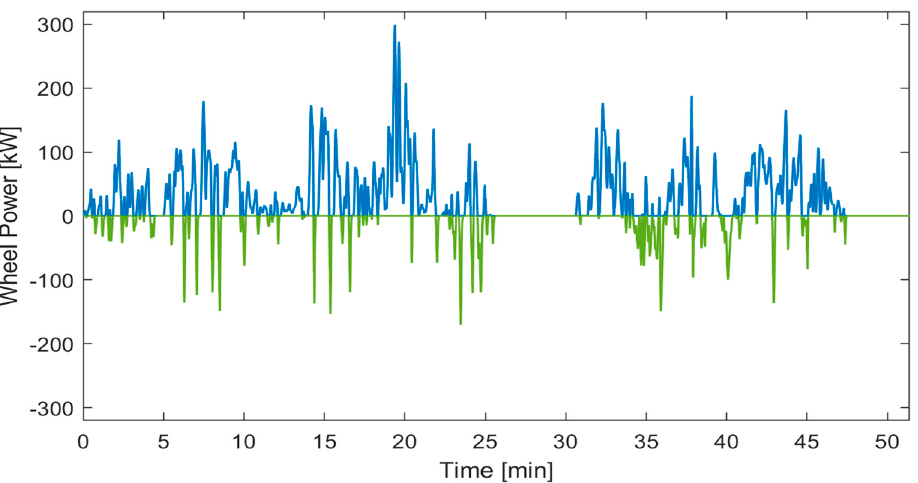
Figure 5. Speed and road grade profiles of vehicle mission.